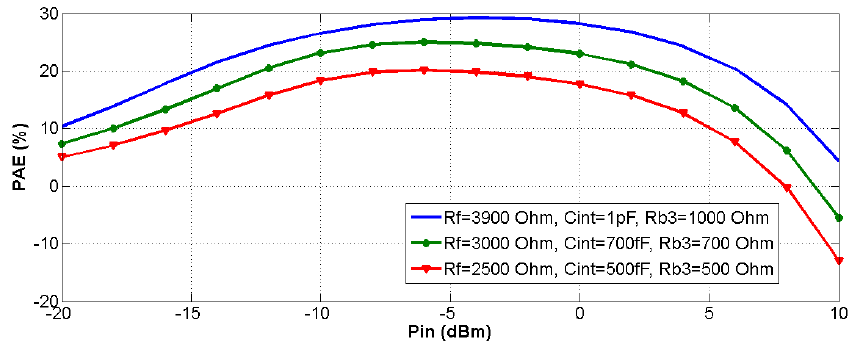
Figure 12. Effect of resistors R f and R b 3 and capacitor C INT on